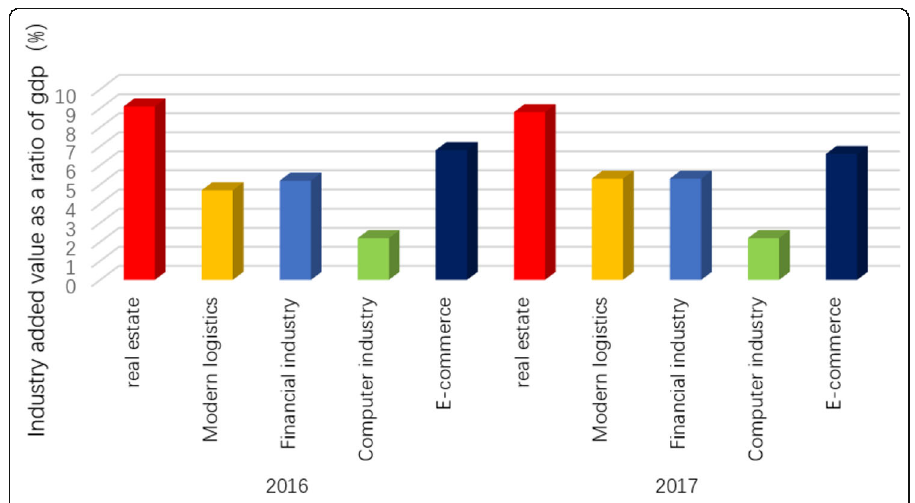
Fig. 6 Comparison of the contribution of logistics and e-commerce and other service industries